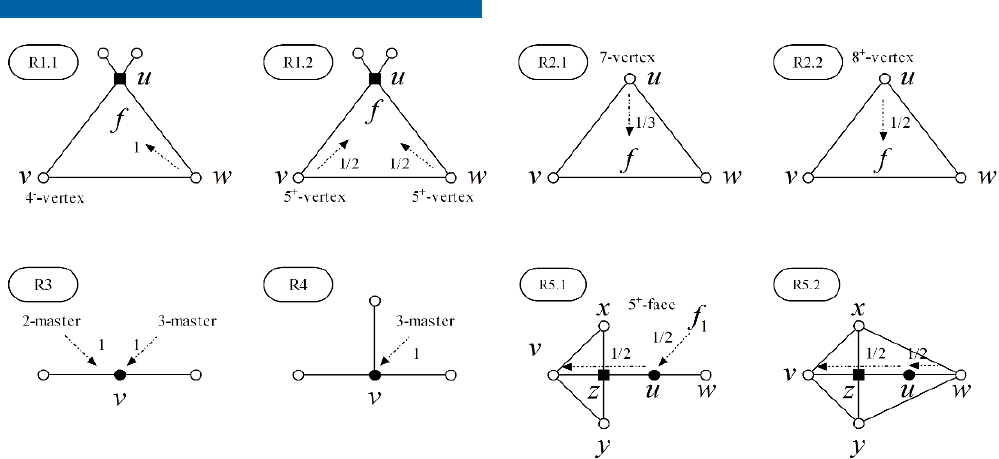
Figure 4. Discharging rules for the proof of Theorem